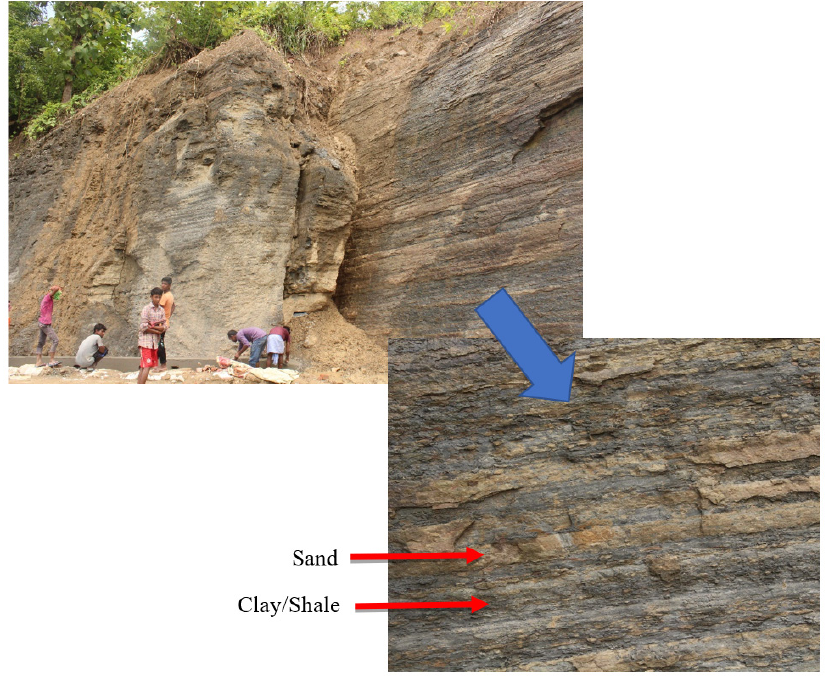
Figure 5. Different layers of soils at Shapchari Shal Bagan located in the landslide areas.